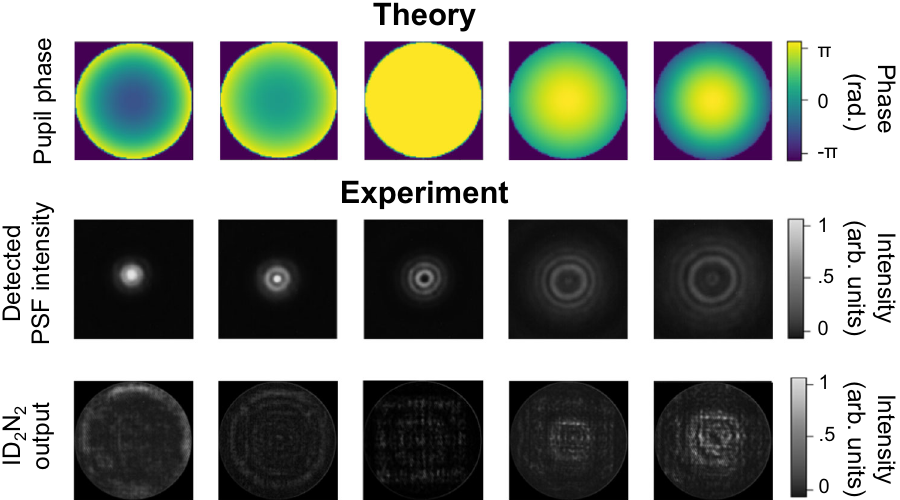
Fig. 5 | ID 2 N 2 non-degenerate response to defocus. Defocus (Z 4 ) terms applied and corresponding detected PSF intensities and ID 2 N 2 outputs. The amplitude of the pupil phases is scanned from − π s to + π radians, the PSF are detected at the